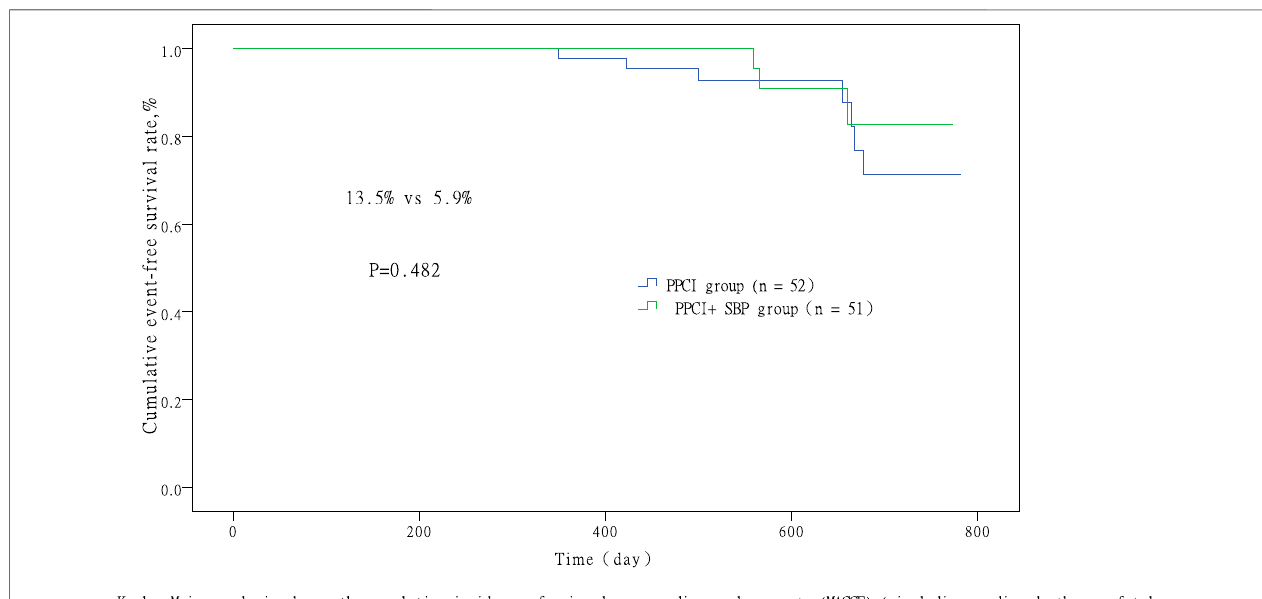
FIGURE 2 | Comparison of the cumulative incidence of MACCE between the PPCI and PPCI + SBP group.